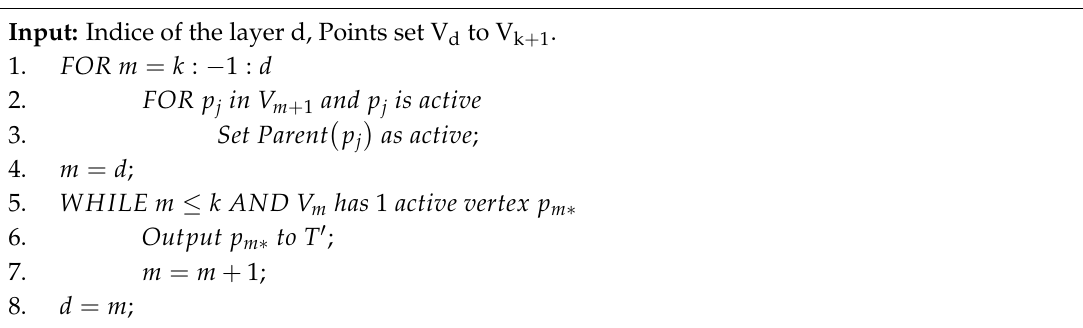
Algorithm 3. Real-Time Output (Iteration k